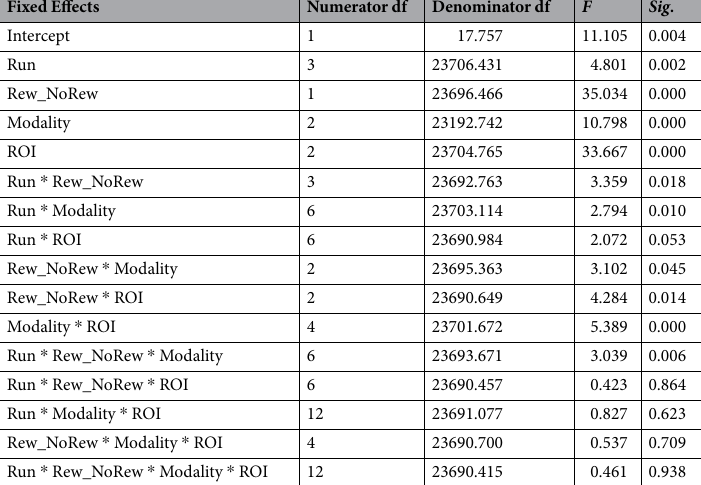
Table 2. Model results for Reward vs. No Reward, Run, Modality, and